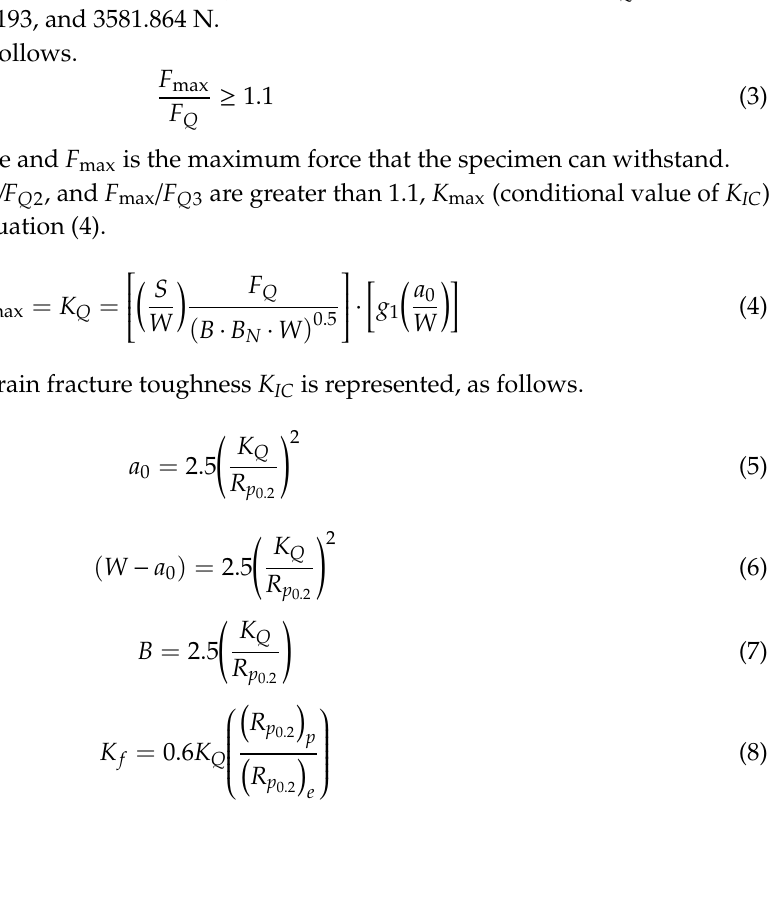
Figure 6. Displacement-force (P-V) curve of three-point bending. Table 3. Tensile test results.